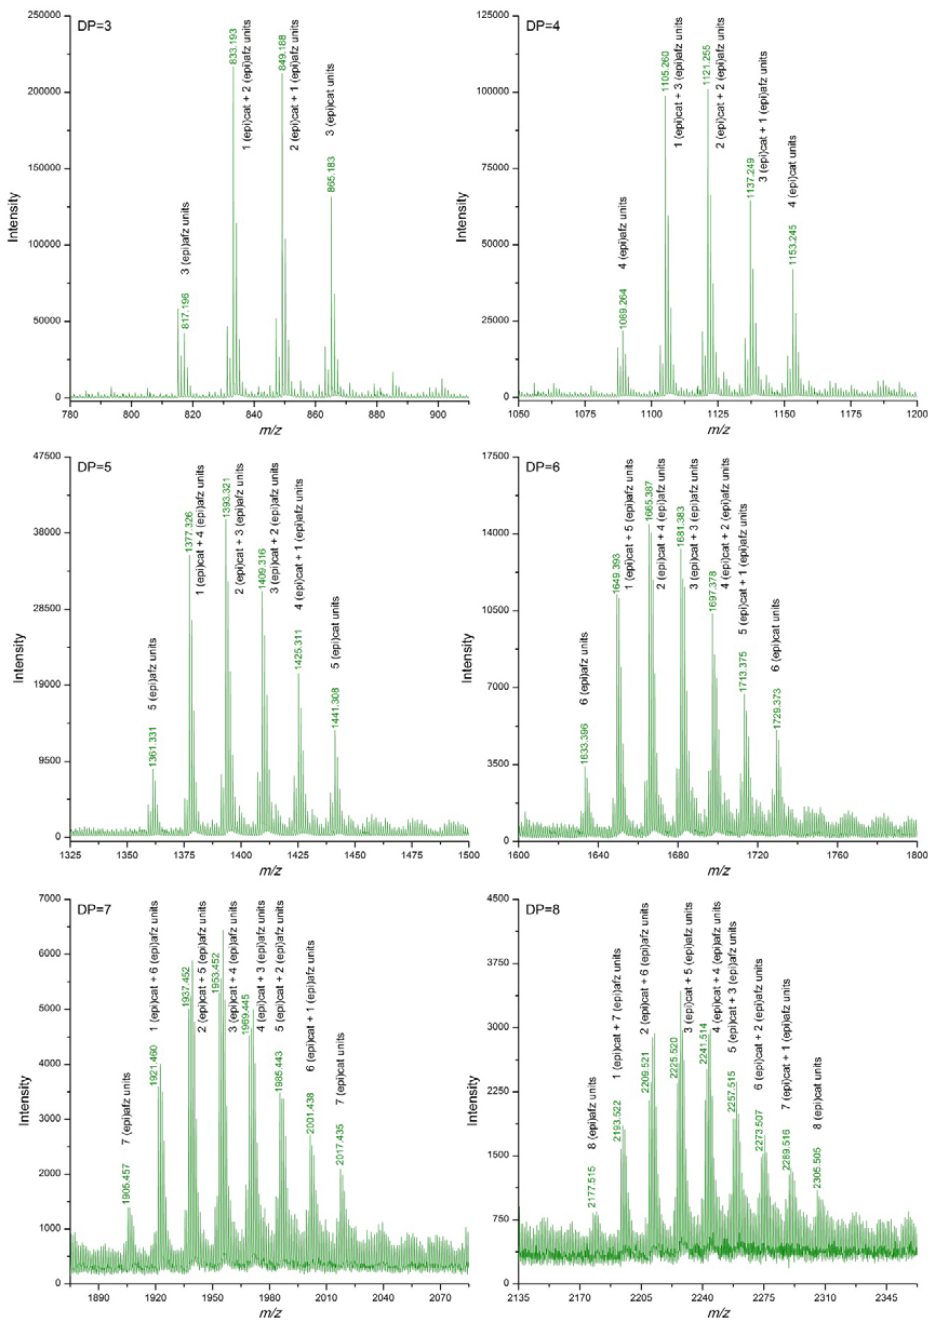
Figure 2. Enlargements of DI-ESI-QTOF mass spectrum of proanthocyanidins with DP 3–8 from a sample of U. tomentosa leaves from Sarapiquí location.